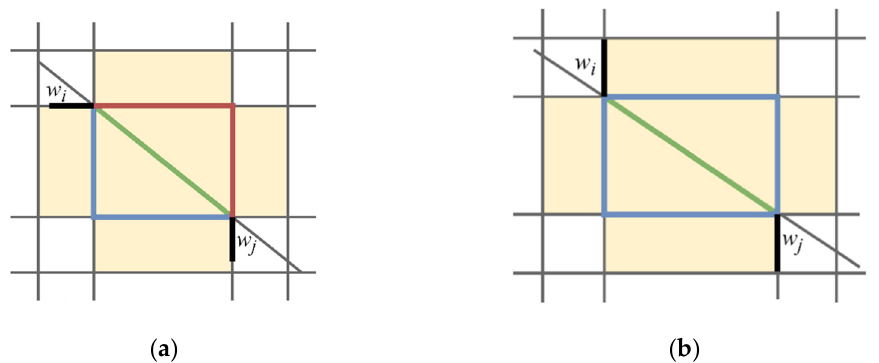
Figure 6. Potential wall segment connection schemes: ( a ) non-parallel wall segment connection scheme; ( b ) parallel wall segment connection scheme. Where W i and W j represent disjoint wall segments with topological relationships. The red lines represent intersecting schemas; the blue lines represent orthogonal schemas; and the green lines represent directly connected schemas. The gray lines represent the division of the free-space evidence raster. Yellow cells will be labeled in next step to finalize connection scheme between W i and W j